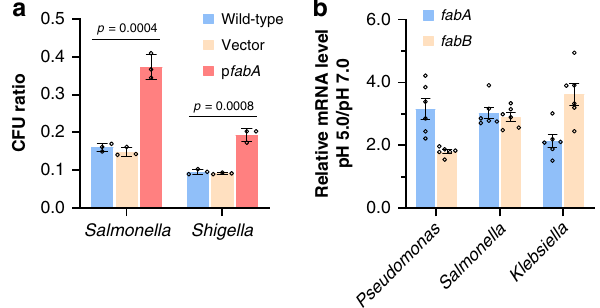
Fig. 6 The exponential phase ATR system based on UFAs and CpxRA is conserved in bacteria. a Acid tolerance of Salmonella Typhimurium LT2 and Shigella fl exneri 2a str. 2457T wild-type strain and strains carrying empty vector or p fabA after acidic challenge at pH 5.0 for 1 h ( n = 3 biologically independent samples). b Relative mRNA level of fabA and fabB in Salmonella Typhimurium LT2, Klebsiella pneumoniae ATCC25955 and Pseudomonas aeruginosa PAO1 grown at pH 7.0 and pH 5.0 ( n = 2 biologically independent samples with three technical repeats). Error bars, mean ± SEM.